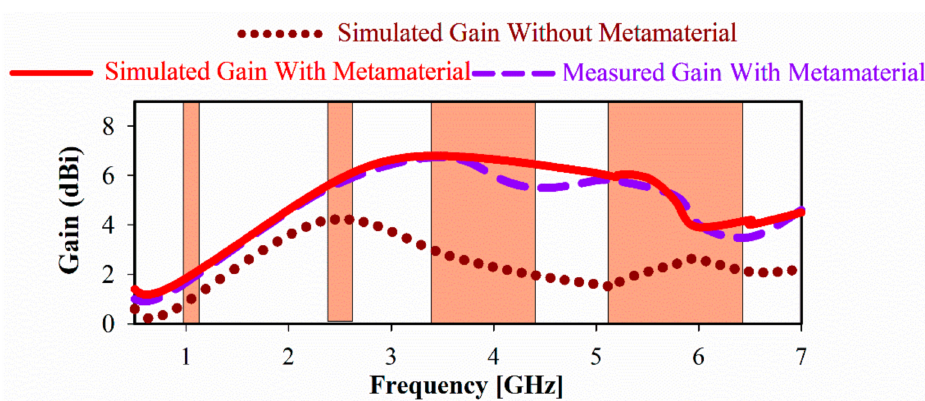
Figure 14. A measured and simulated gain of proposed CPW antenna with and without MTM.